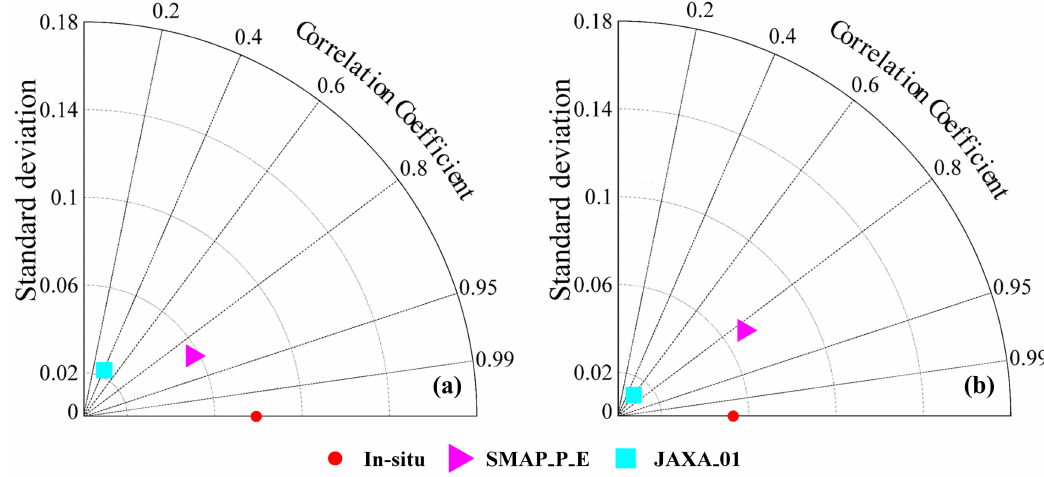
Figure 6. Taylor diagram illustrating the statistics of the comparison between station-averaged soil moisture and satellite soil moisture, with a spatial resolution of 0.1 ◦ , for the ( a ) LWW and ( b ) REMEDHUS